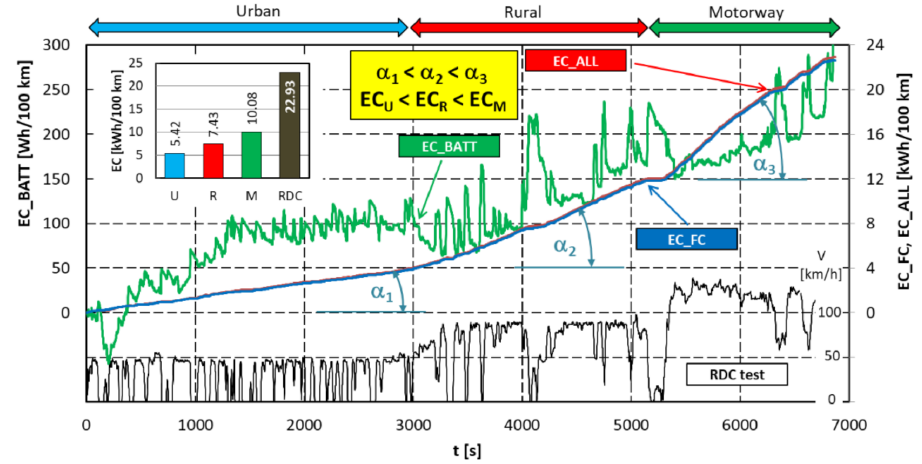
Figure 8. Energy consumption conditions in the RDC test phases (EC U —energy consump- tion in urban phase, EC R —energy consumption in rural phase, EC M —energy consumption in motorway